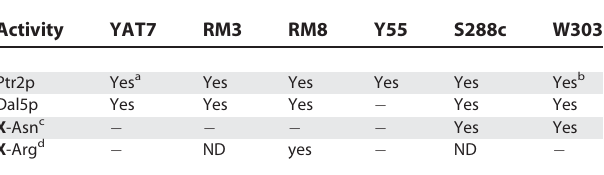
Table 2. Activities Contributing to the Utilization of Dipeptides as a Nitrogen Source in Each Strain Background